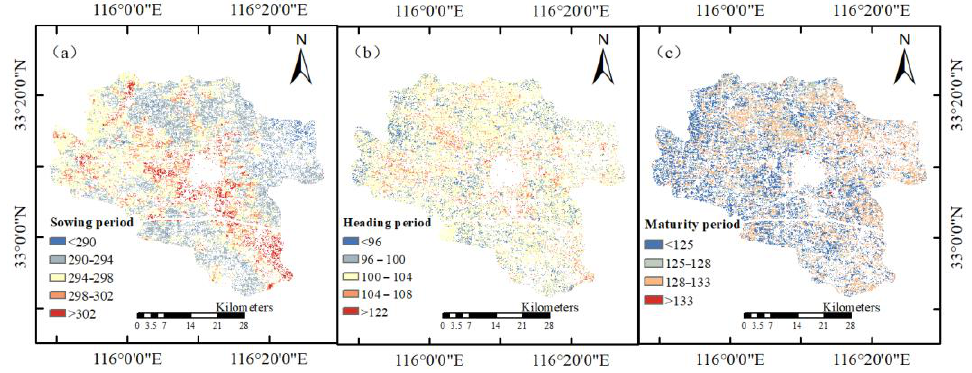
Figure 6. Spatial distribution of wheat phenological periods in Lixin County, 2020–2021. ( a ) Sowing period; ( b ) Heading period; ( c ) Maturity period.